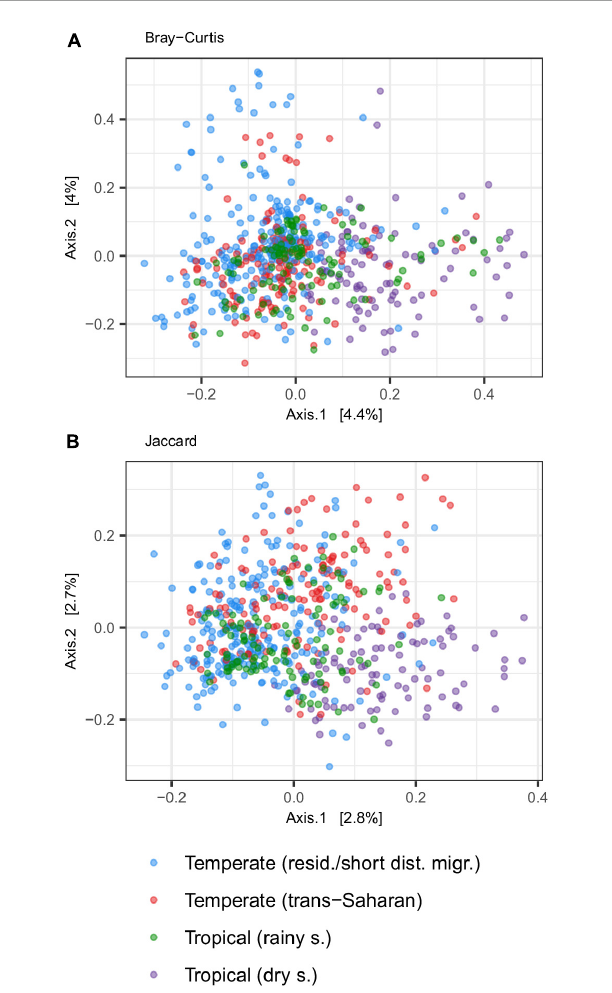
FIGURE2 Gut microbiota (GM) differentiation among tropical passerines collected during dry or rainy season and trans-Saharan migrants or residents/short-distance migrants collected in temperate zone according to PCoA ordination. PCoA was performed on two types of community distances [ (A) Jaccard and (B)